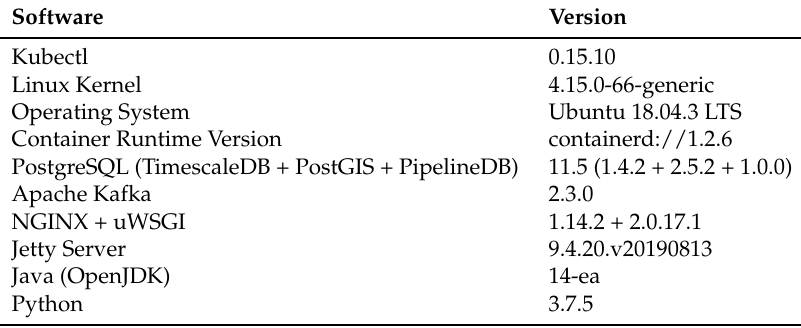
Table 2. Versions of the software used in the experimental setup.